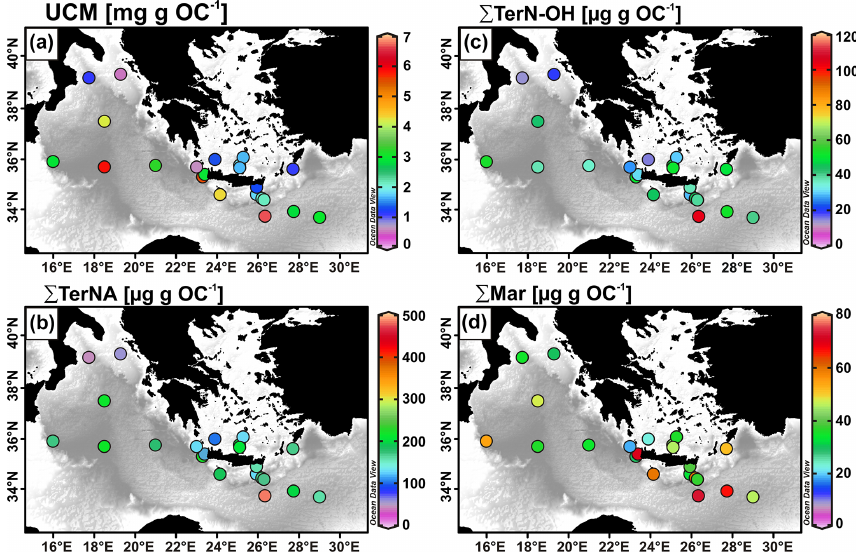
Figure 4. Spatial distributions of the OC-normalized concentrations of (a) unresolved complex mixture (UCM), (b) P TerNA, (c) P TerN- OH and (d) P Mar in surface sediments of the deep eastern Mediterranean Sea. Abbreviations of lipid biomarkers are defined in the